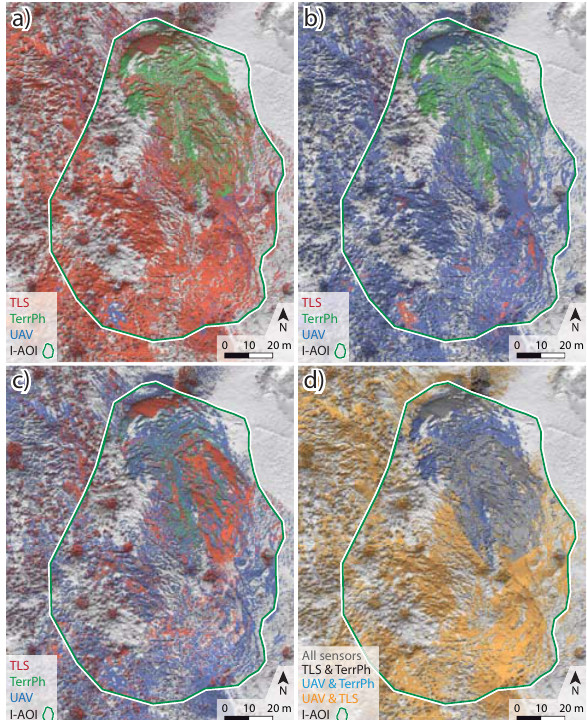
Figure 9. Spatial distribution of the integration decisions for the data of 2016 ( s v = 0 . 2 m) for the applied integration rules ’maximum geometric curvature’ (a), ’maximum planarity’ (b), ’minimum elevation’ (c), and ’sensor correspondence’ (d). The marked point cloud profile is shown in Fig. 11.